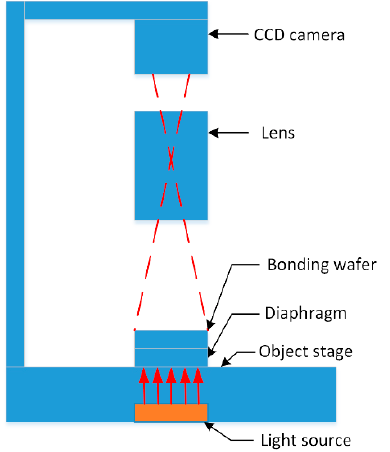
Figure 2. Schematic diagram of the structure of the infrared imaging system.